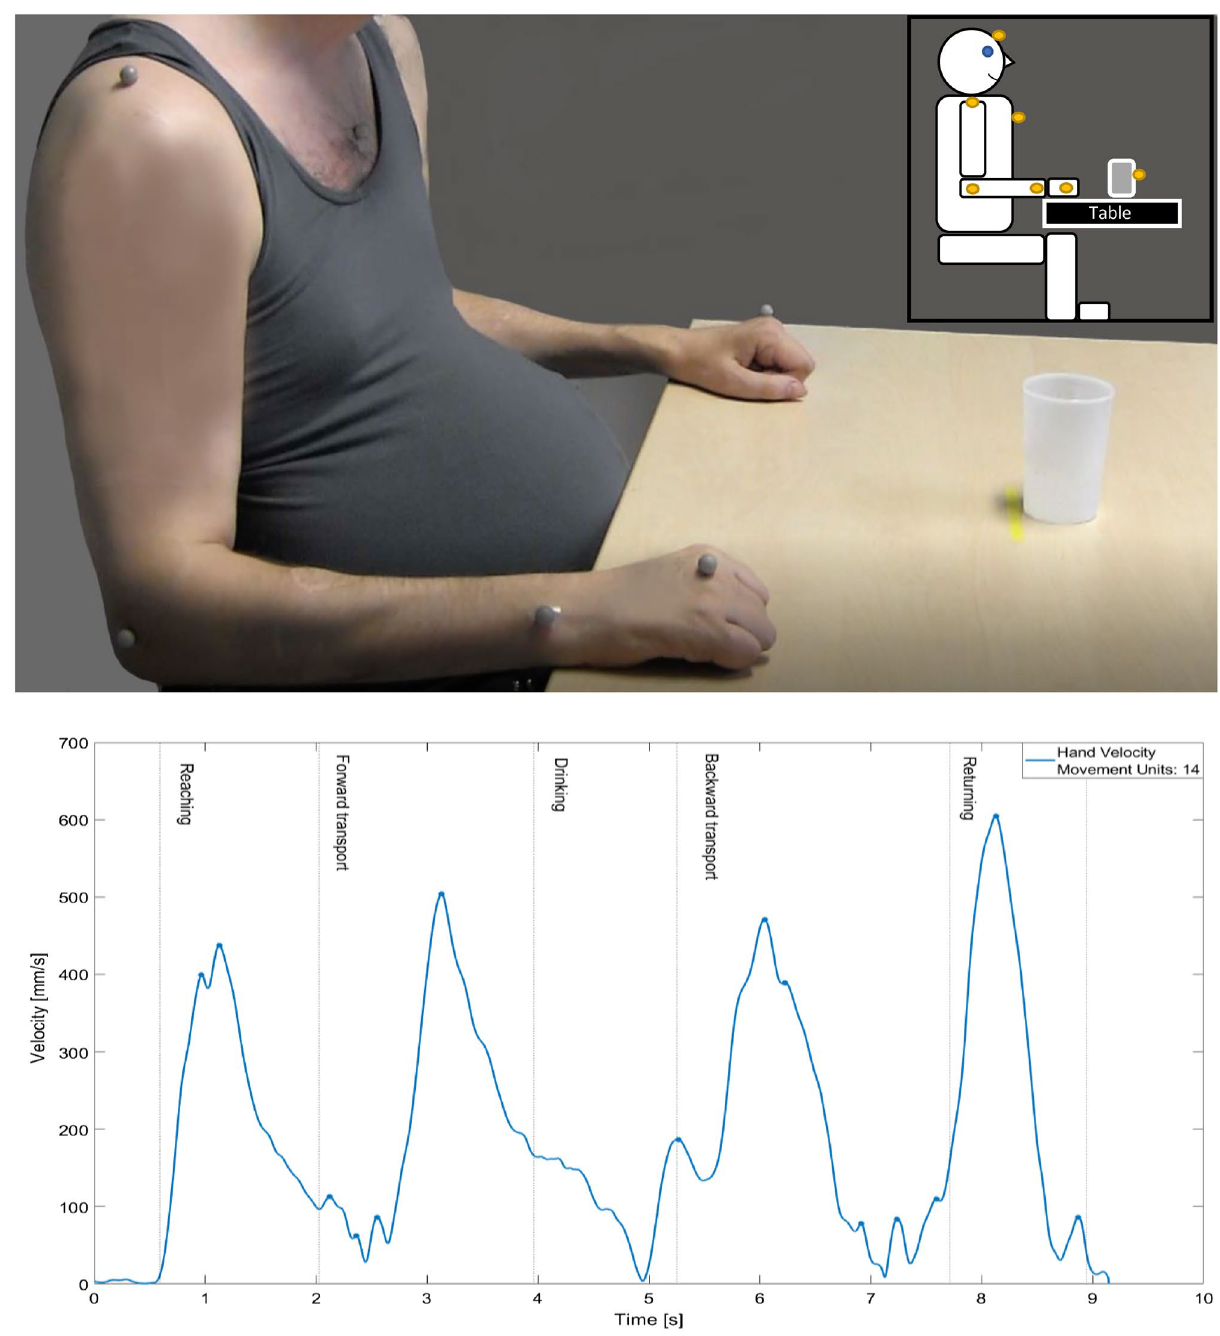
Figure 1. Initial position of the drinking task and placement of markers as well as tangential velocity profiles of hand markers and number of movement units in a participant with C6 AIS C spinal cord